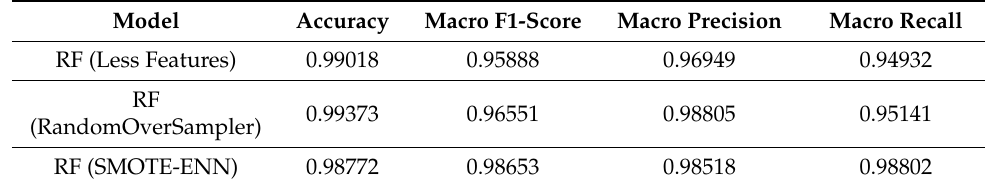
Table 14. Comparison After Up-sampling Methods Applied.